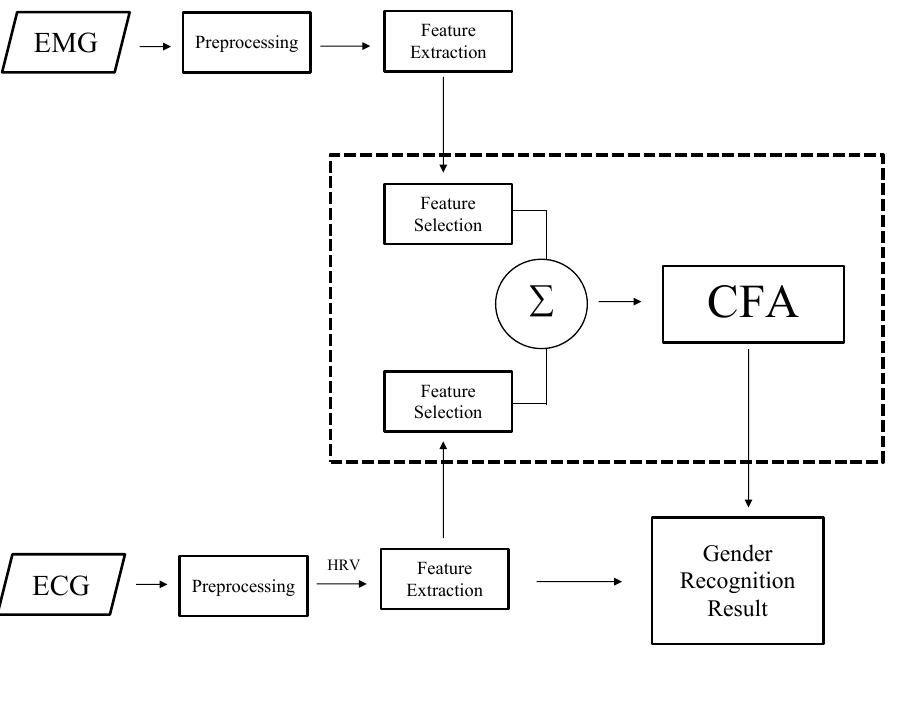
Figure 3. Gender identification process based on electromyography-heart rate variability (EMG-HRV) feature fusion. The selected features of EMG and HRV are combined using Combinatorial Fusion Approach (CFA) to obtain the gender classification